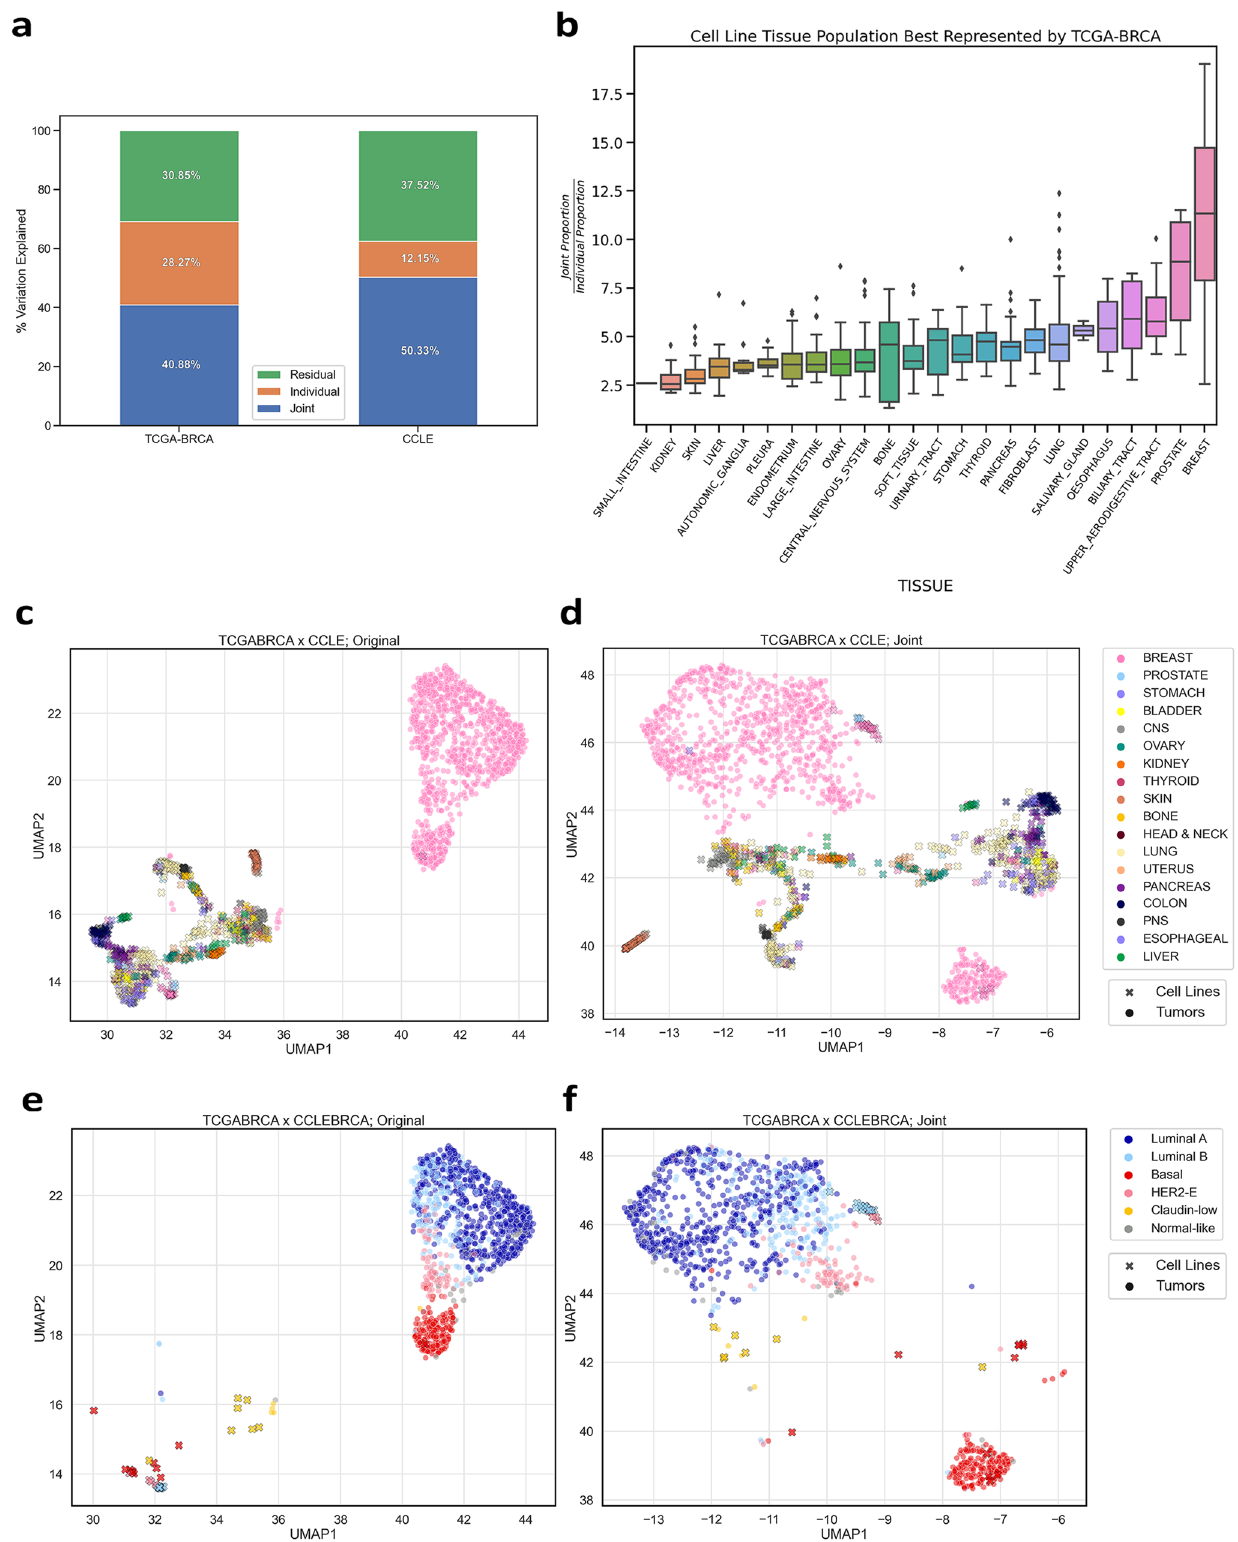
Fig. 2 Joint dimension reduction integration captures relevant cell lines. a Percent of variation identi fi ed as Joint, Individual, or Residual (Noise) by AJIVE after integrating derived cell lines from CCLE with TCGA-BRCA. b Boxplot of the joint-individual proportion ratio for CCLE cell lines grouped by tissue type. High joint proportion and low individual proportion indicates well-represented samples across datasets. 2D projections of combined cell line and breast tumor expression data before integration (Original) and after integration (Joint) using UMAP ( n = 935 cell lines, n = 1102 primary breast tumors). Samples were colored based on tissue type ( c , d ) and PAM50 molecular subtype calls 18 ( e , f